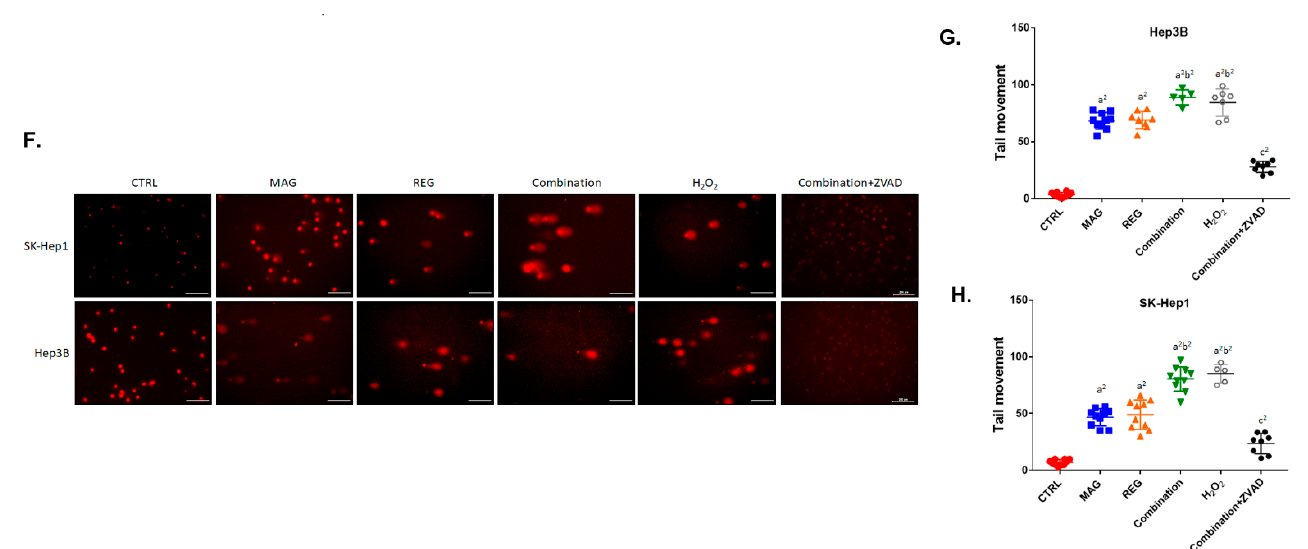
Figure 4. The apoptosis and DNA damage effect of regorafenib was enhanced by magnolol. Hep3B and SK-Hep1 cells were treated with 10 μ M regorafenib, 50 μ M magnolol, and a combination of both for 48 hrs, combined with ZVAD for 30 min, and assayed by flow cytometry with ( A – B ) annexin-V/PI staining and ( C ) cleaved caspase-3. After 48 hrs, the magnolol and regorafenib treatments were also performed with ( D ) PI staining and ( E ) cleaved PARP-1 staining, respectively. H 2 O 2 was used as a positive control in the comet assay. The tail movement pattern of the Hep3B and SK-Hep1 cells were ( F ) photographed and ( G – H ) quantified. (a 2 p < 0.01 vs. CTRL; b 2 p < 0.01 vs. 10 μ M REG or 50 μ M MAG; c 2 p < 0.01 vs. treatment groups without ZVAD; scale bar = 200 μ m).